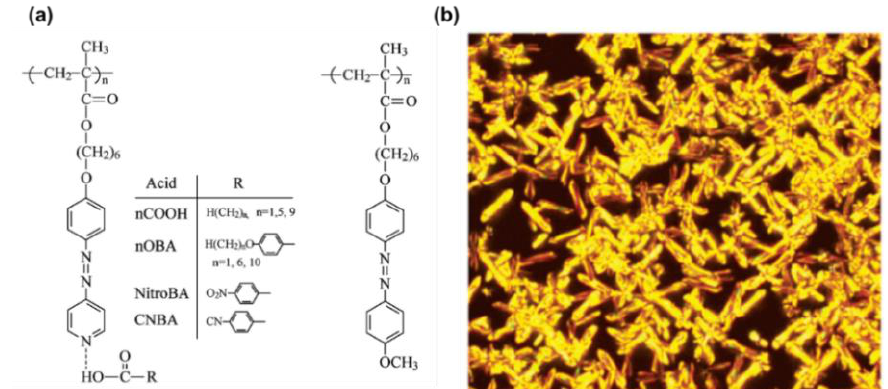
Figure 4. ( a ) Chemical structures of the amorphous azopyridine polymer and a liquid–crystalline azobenzene polymer counterpart. ( b ) Polarizing optical micrographs for PAzPy complexed with ( a ) acetic acid (1COOH), annealed at 63 °C. Reprinted with permission from Reference [52] . Copyright 2004, American Chemical Society.